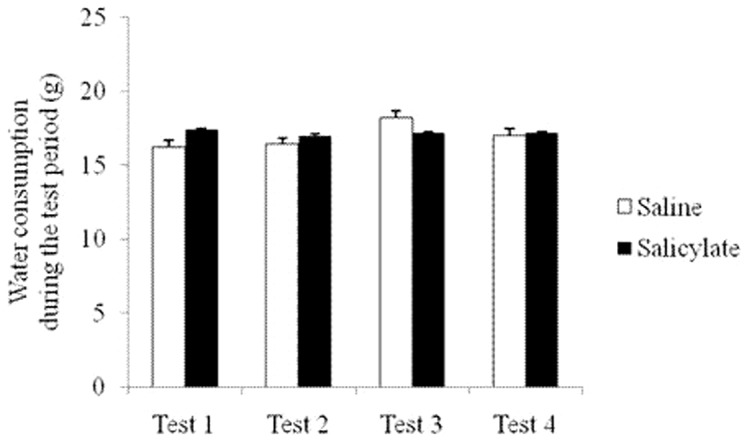
Water consumption during the 4 days in the test period. Tests 1–4 show the 1st, 2nd, 3rd, and 4th day, respectively. Vertical bars represent mean ± standard error (SEM).